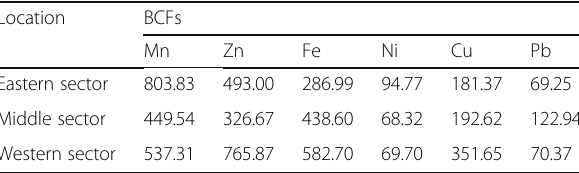
Table 10 Bioconcentration factors (BCFs) of heavy metals in muscles of Oreochromis niloticus fish Location